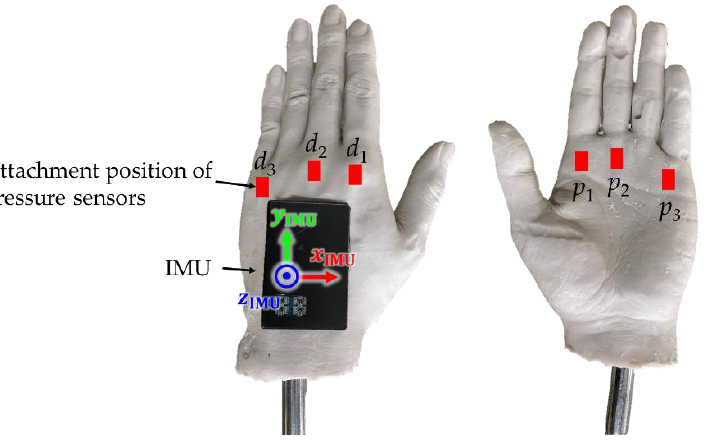
Figure 2. Attachment position of pressure sensors and IMU.